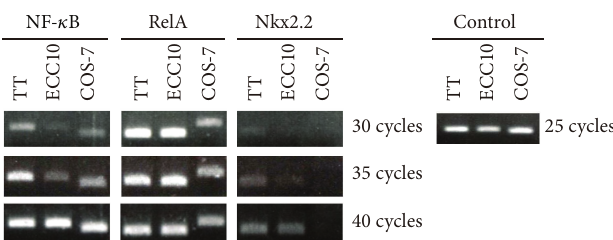
Figure 9: Expression of transcription factors in TT, ECC10, and COS-7 cells. PCR products were separated by agarose gel electrophoresis and stained with ethidium bromide. Human Nkx2.2, NF- 𝜅 B (NF- 𝜅 B (p50)), and RelA (NF- 𝜅 B (p65)) primer sets were used for TT and ECC10 cells. African green monkey Nkx2.2, NF- 𝜅 B, and RelA primer sets were used for COA-7 cell. Controls were human GAPDH for TT and ECC10 cells and African green monkey GAPDH for COA-7